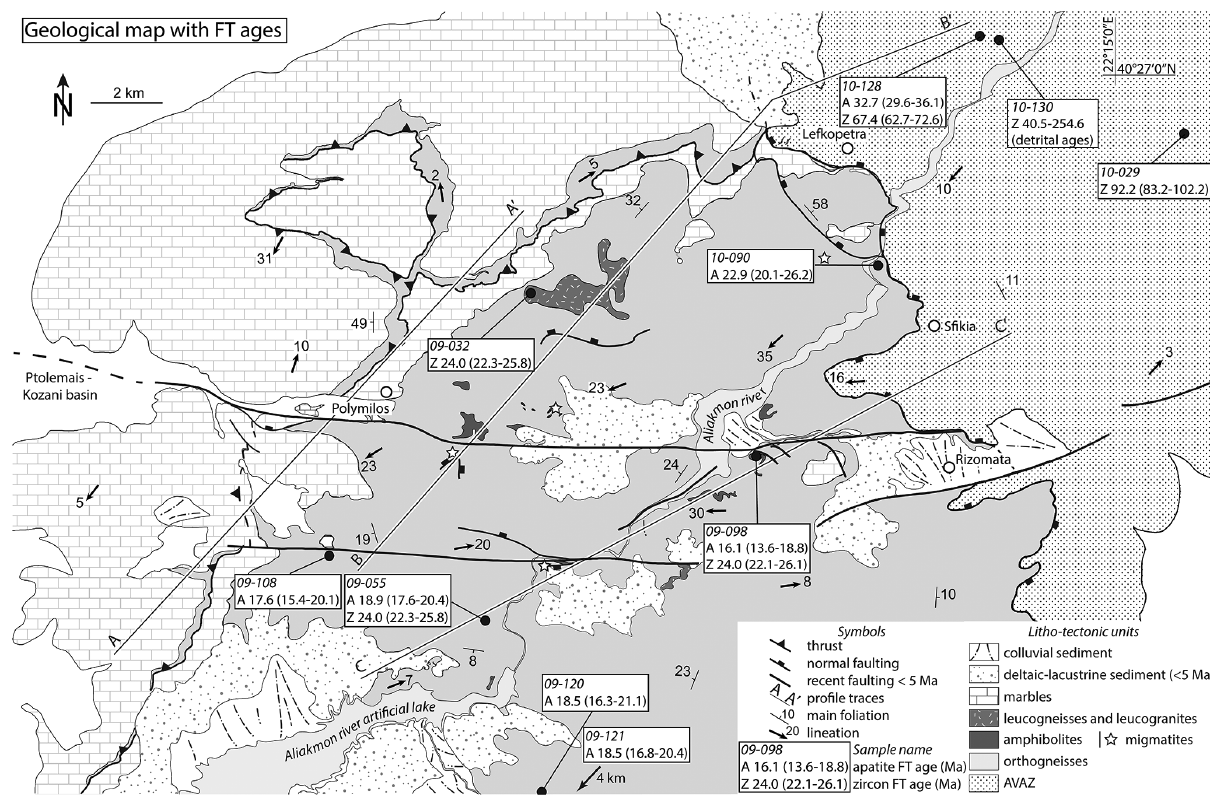
Figure 4. Location and age of FT samples (pooled age and 68% confidence interval) on the geological map (located in Fig. 1) of the eastern Pelagonian gneiss dome (Schenker, 2014). For the detrital zircons of sample 10-130, the range of single-grain ages is reported.